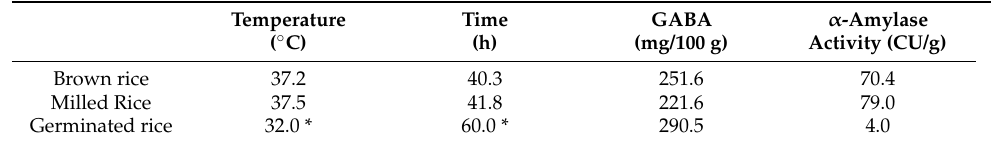
Table 3. Predicted maximum GABA and α -amylase activity according to the simultaneous linear optimisation of both adjusted quadratic models (Table 2). α -Amylase Temperature Time GABA ( ◦ C) (h) (mg/100 g) Activity (CU/g) Brown rice